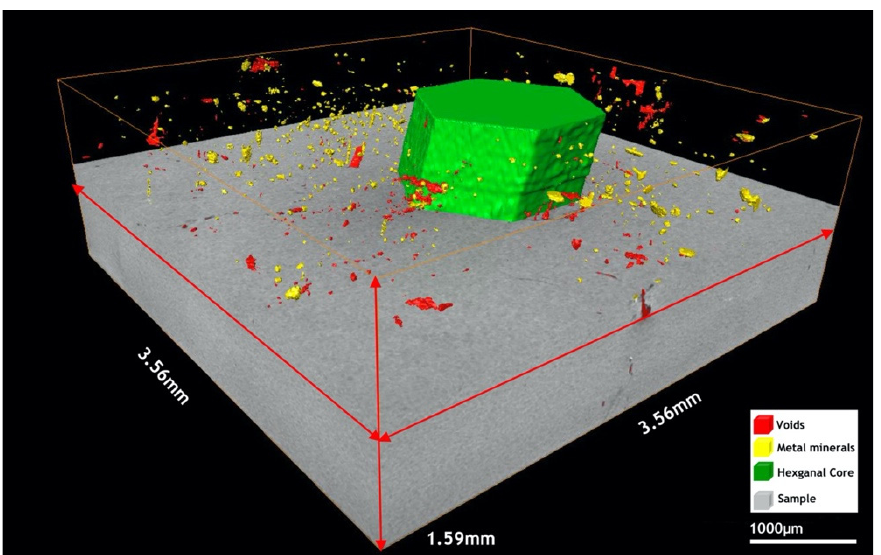
Figure 28. The reconstructed images demonstrated the distribution of fluid, minerals, and the core within the emerald host in a three-dimensional way.